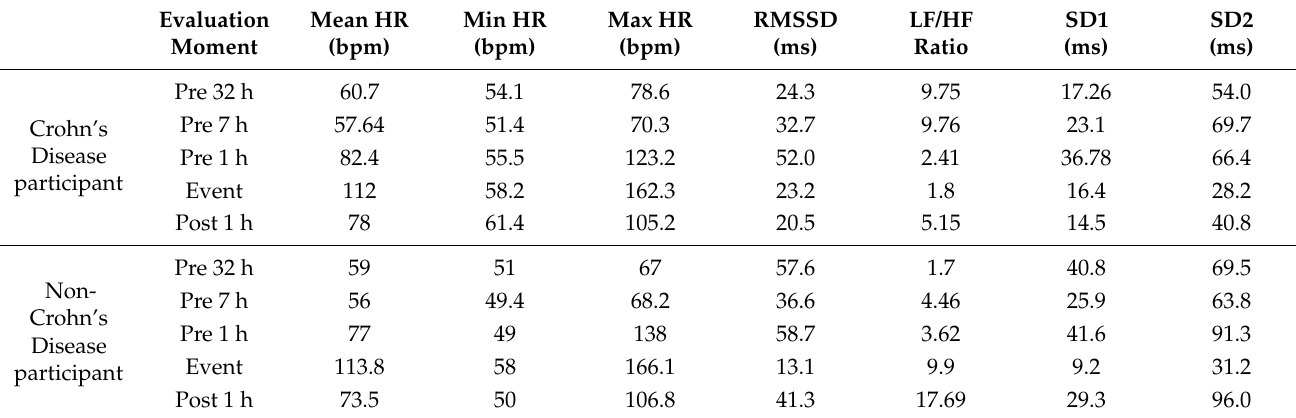
Table 3. Heart rate variability modifications of